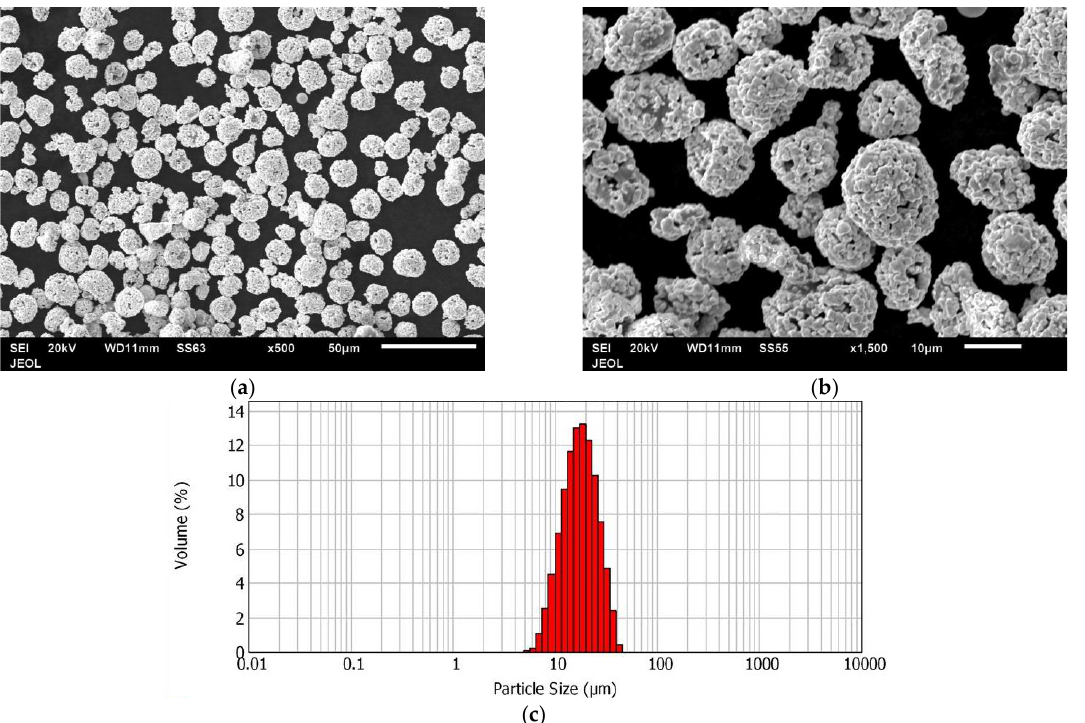
Figure 3. SEM Images of WC-12Co powder at two magnifications: ( a ) ×500, ( b ) ×1500, and ( c ) particle size distribution.